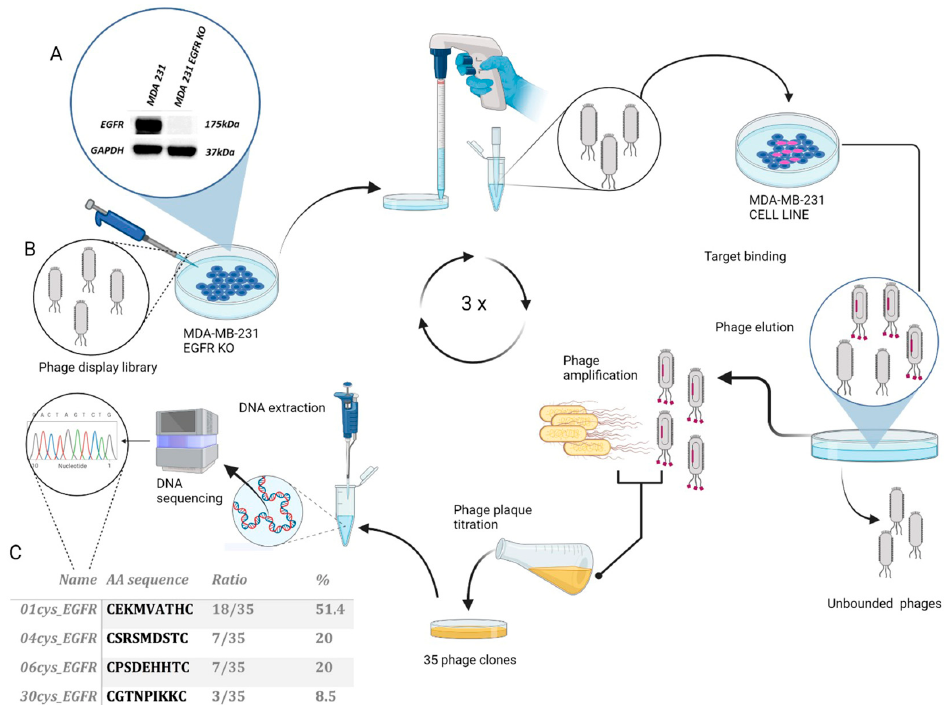
Figure 1. Selection and identification of peptide ligands for EGFR in the TNBC cell line MDA-MB231. Schematic representation of phage display screening: ( A ) Protein expression levels of EGFR in MDA-MB-231 wild-type and EGFR KO cells were verified by Western blot analysis; GAPDH expression was included as loading control. ( B ) Non-specifically bound phages were eliminated by incubation of the library with MDA-MB-231 EGFR KO cells. Unbound phages were then incubated with MDA-MB-231 overexpressing EGFR to select phages with high affinity binding. Three cycles of selection and amplification were performed with increasing stringency conditions. The genomic DNA of selected phage clones was extracted and sequenced to determine the peptide insert required for EGFR binding. ( C ) Peptide sequence and occurrence frequency of selected phage